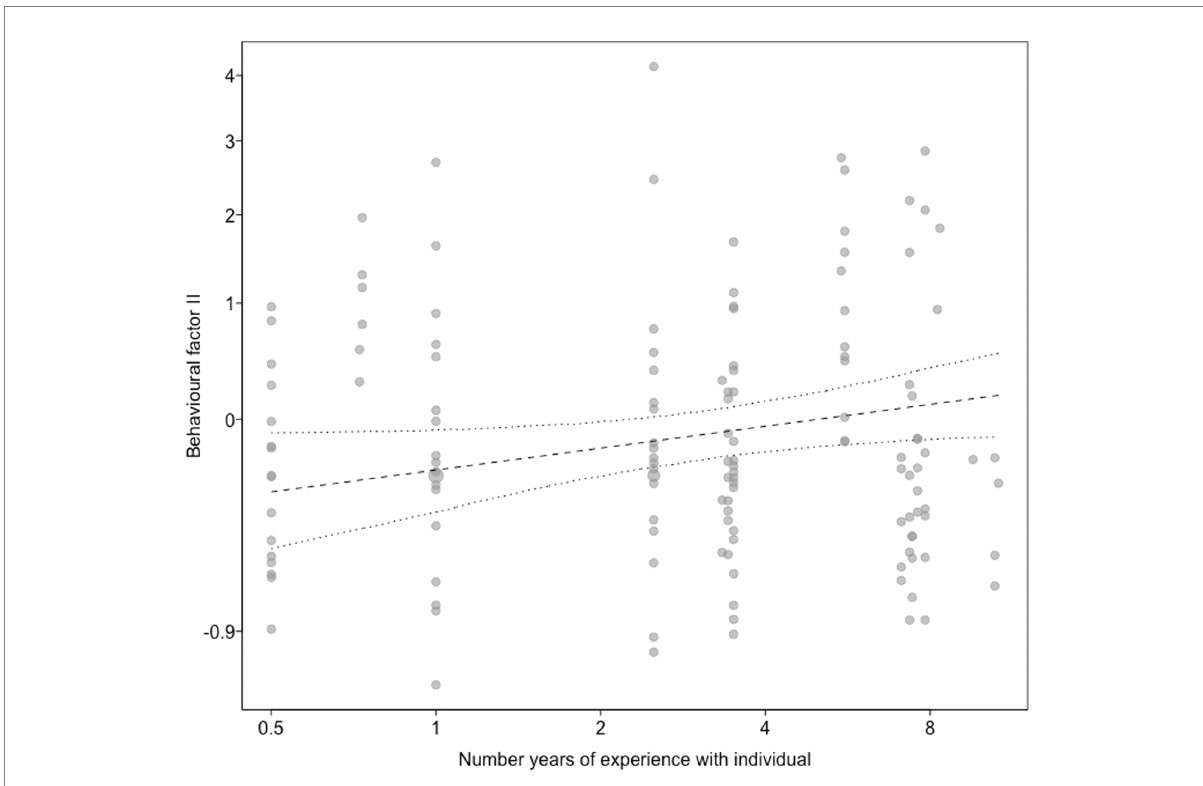
FIGURE 2 Behavioral factor II ( y -axis) as a function of the number of years of experience with the individual ( x -axis). Dots show the individual data, the straight line represents the predictive mean of the model, and the dashed on dotted lines the fitted model and its 95% confidence limits with all other predictors centered to a mean of zero. Behavioral factor II was mainly correlated with proportion time tail wagging, proportion time licking trainer’s hand or face, and numbers of lips